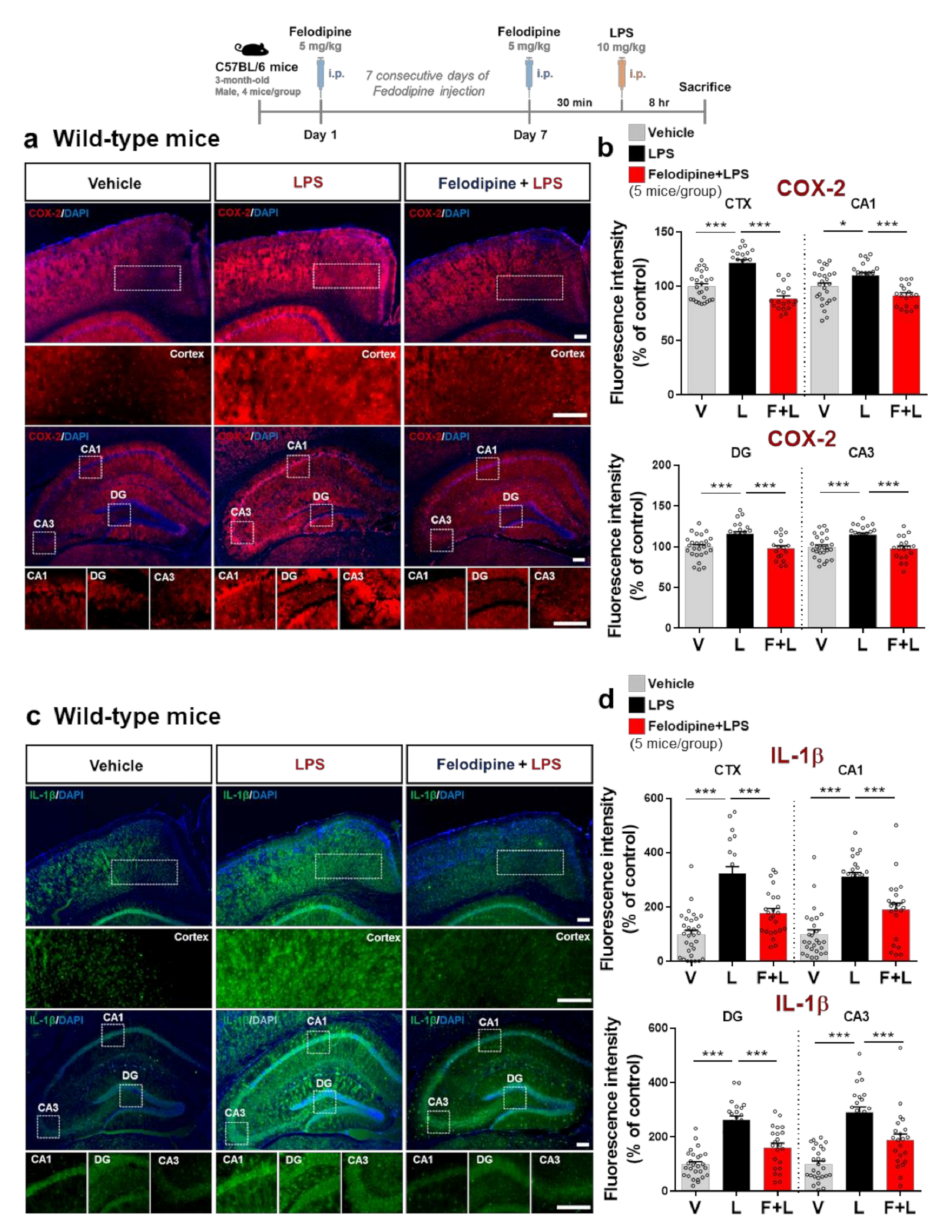
Figure 7. Daily administration of felodipine for 7 days downregulates LPS-induced proinflammatory cytokine COX-2 and IL-1 β levels in C57BL/6 mice. ( a , c ) Immunofluorescence staining of proinflam- matory cytokine COX-2 and IL-1 β expression in brain slices from C57BL/6 mice injected daily with vehicle (5% Tween-20 + 5% PEG300 in saline) or felodipine (5 mg/kg, i.p.) for 7 days, followed by LPS (10 mg/kg, i.p.) or PBS on day 7. ( b , d ) Quantification of data from ( a , c ) (vehicle, n = 5 mice/group, n = 26 brain slices; LPS, n = 22 brain slices; felodipine+LPS, n = 18 brain slices. * p < 0.05, *** p < 0.001, scale bar = 100 µ M. V: vehicle; L: LPS; F or Felodi: